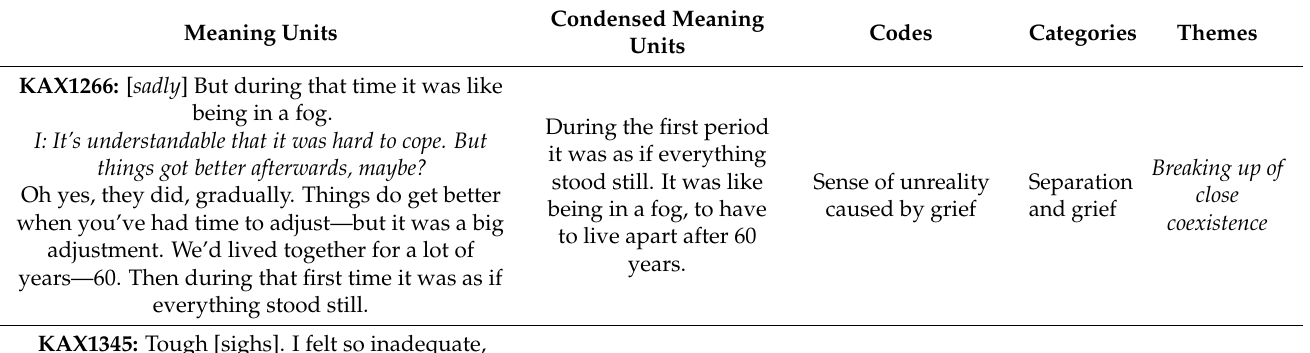
Table 2. Examples illustrating the analytical